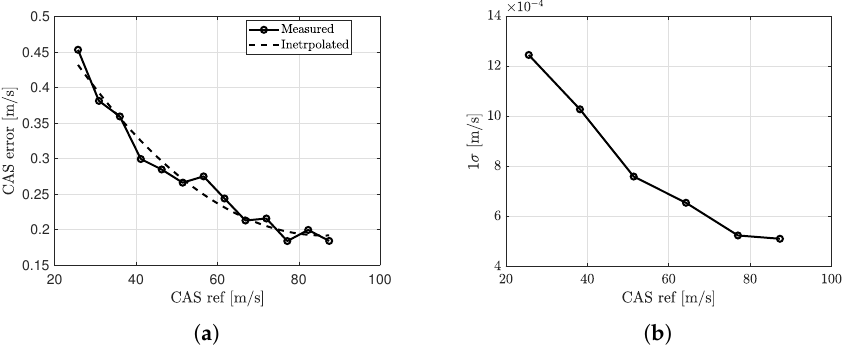
Figure 6. Calibrated airspeed analysis. ( a ) Measured and calibration of the IAS calculated by the ASSE demonstrator, ( b ) Noise on the CAS